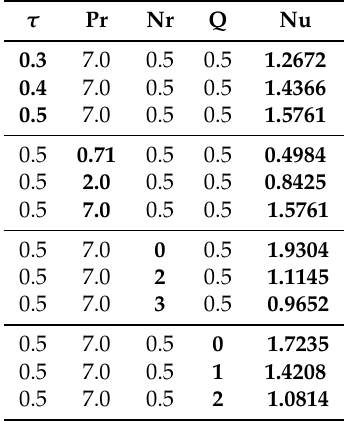
Table 1. Varaition of Nusselt number for different values of parameters.